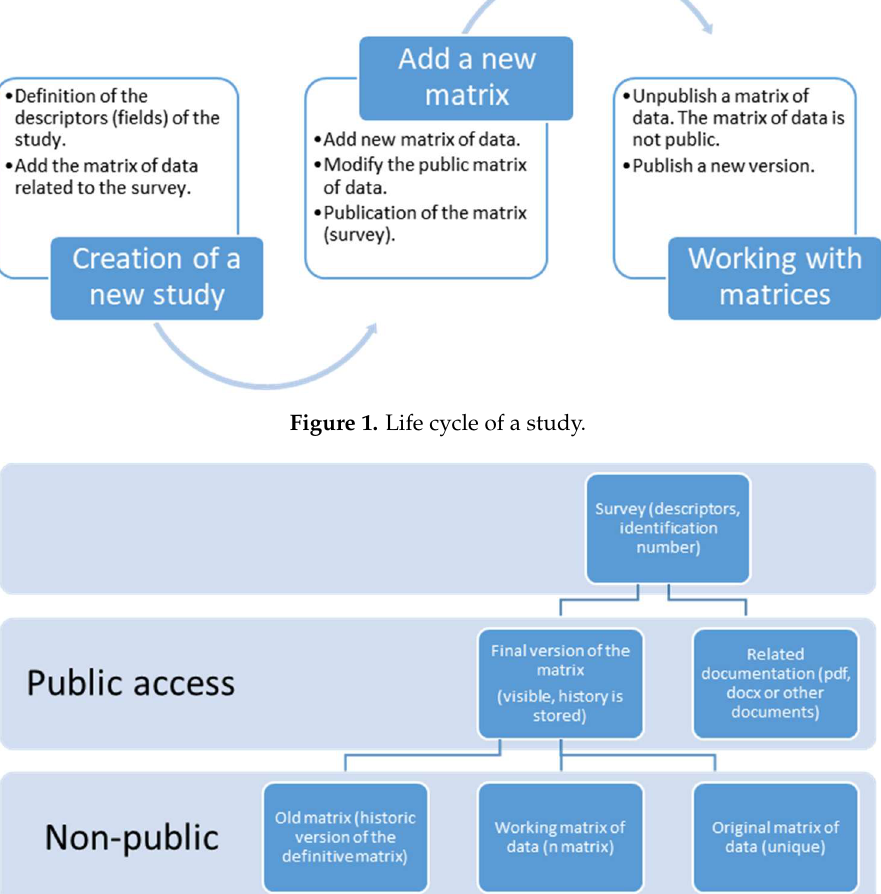
Figure 2. Statistical study structure.